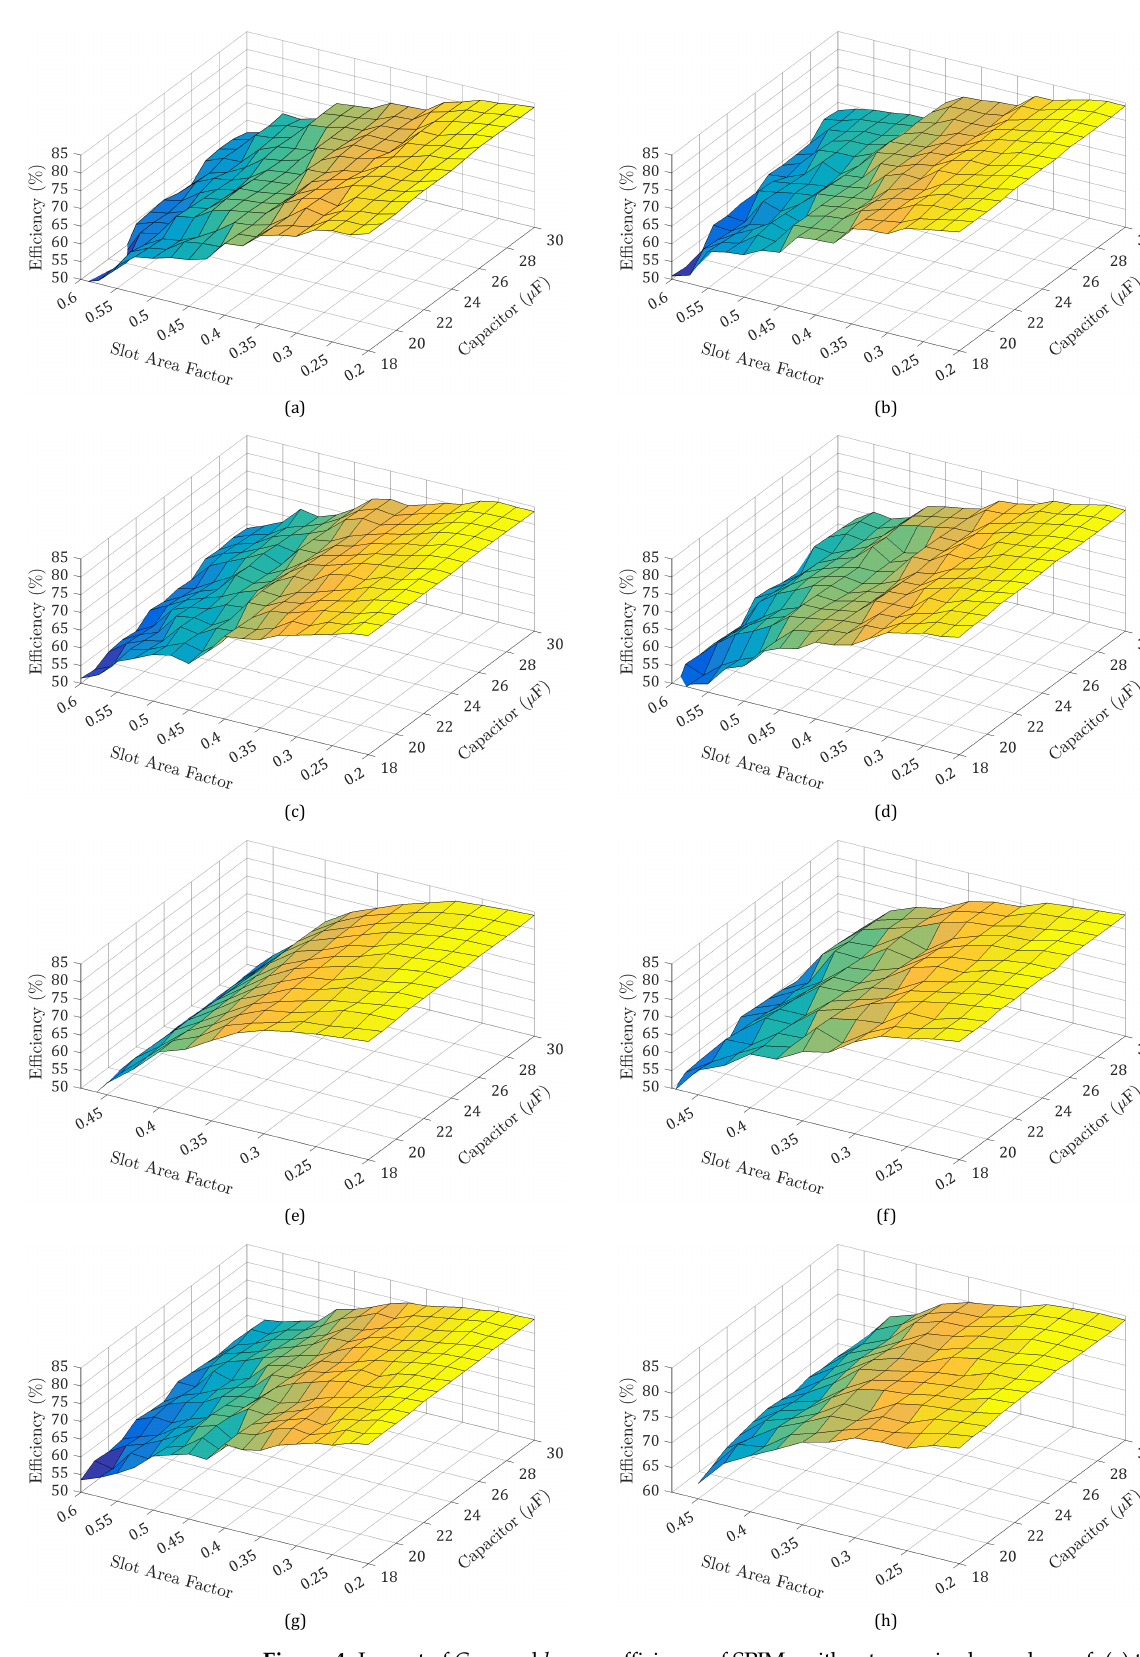
Figure 4. Impact of C run and k bar on efficiency of SPIMs with rotor squirrel-cage bars of: ( a ) trapezoidal, ( b ) oval, ( c ) pent, ( d ) polygonical, ( e ) round, ( f ) drop, ( g ) rectangular, and ( h ) quadrangular